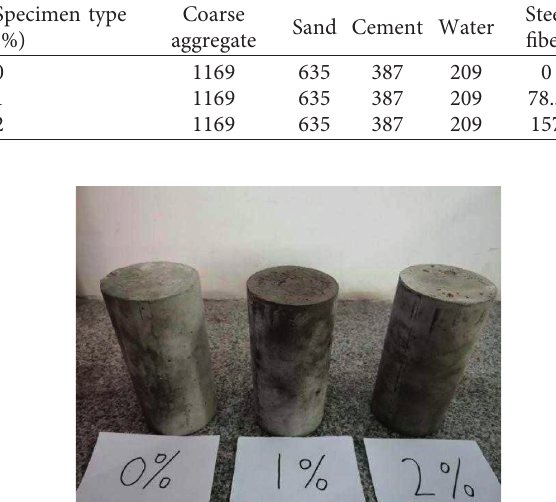
Figure 2: SFRC concrete cylinders.